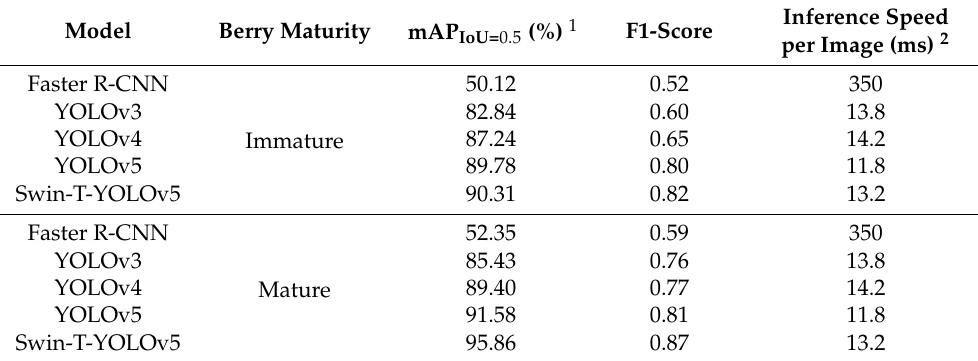
Figure 6. The number of grape bunches comparison between in-field manual counting (gTruth), manual label, and detection using Swin-transformer-YOLOv5 (Swin-T-YOLOv5) with ( a ) Chardonnay (sunny); ( b ) Merlot (sunny); ( c ) Chardonnay (cloudy); and ( d ) Merlot (cloudy). RMSE refers to root mean square error. Plant# refers to the number of plants. Table 6. Model comparison using the test set at two berry maturity